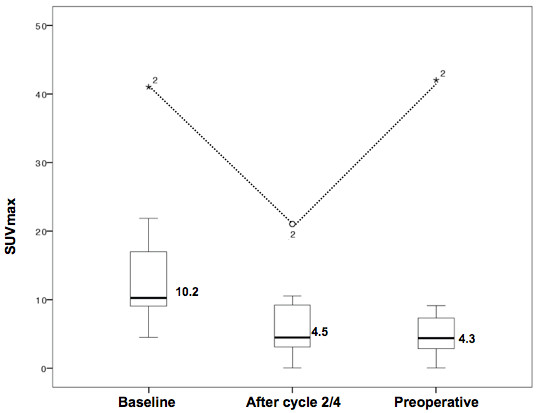
Box and whiskers plot of median SUV max value at baseline, after 2–4 cycles of preoperative chemotherapy and preoperatively in 10 patients with positive PET scans at diagnosis. *2 represents the only outlier value (SUV max 42, 21, 41).